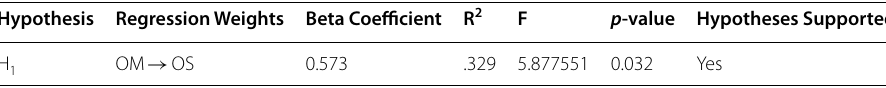
Table 13 Summary of Result from Hypothesis 1 testing